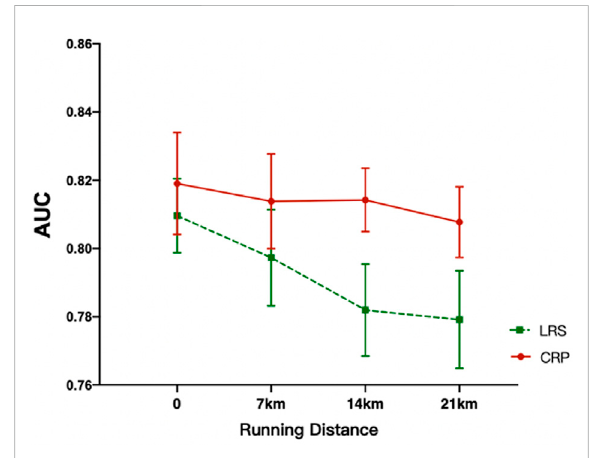
FIGURE 5 Knee fl exion proprioceptive acuity at different running distances in the CRP and LRS conditions. CRP, compression running pants; LRS, loose running shorts. * = p < 0.05; AUC, area under the receiver operating characteristic